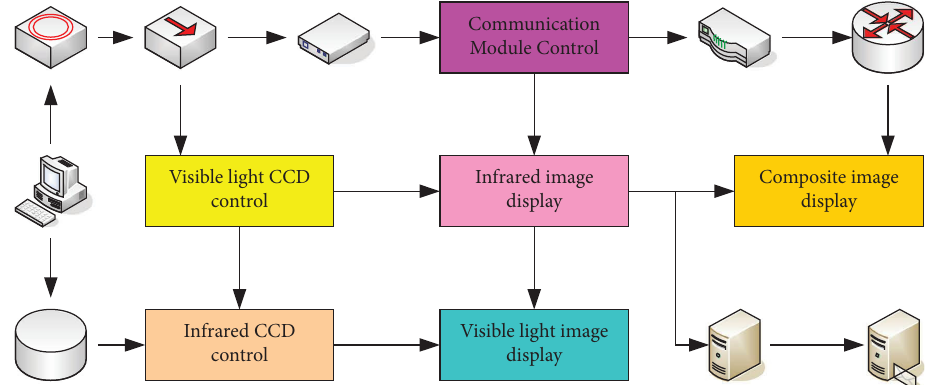
Figure 2: Multimedia quality evaluation platform relying on intelligent robot numerical control